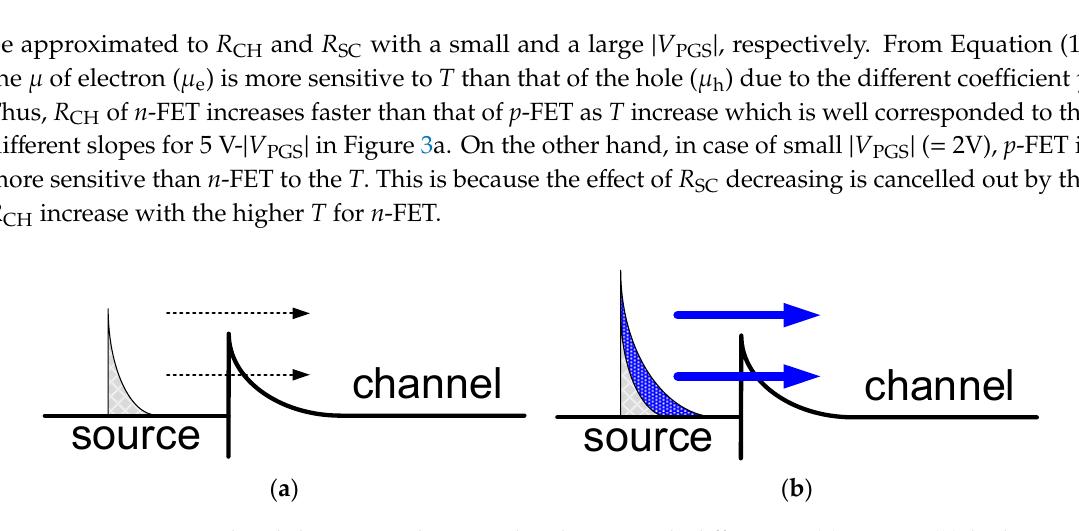
Figure 4. Energy band diagram and carrier distribution with different T . ( a ) Low T ; ( b ) high T . The energy band is plotted along the source and channel (Figure 1). The blue-colored areas in the source represent the increased carrier distribution due to the increased T , and blue-colored arrows indicate the increased carriers passing through the Schottky barrier (SB) due to the increased T .